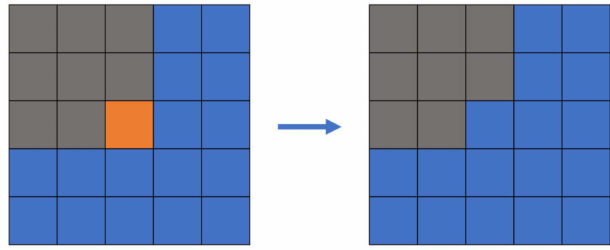
Figure 10. 5 × 5 window size mode